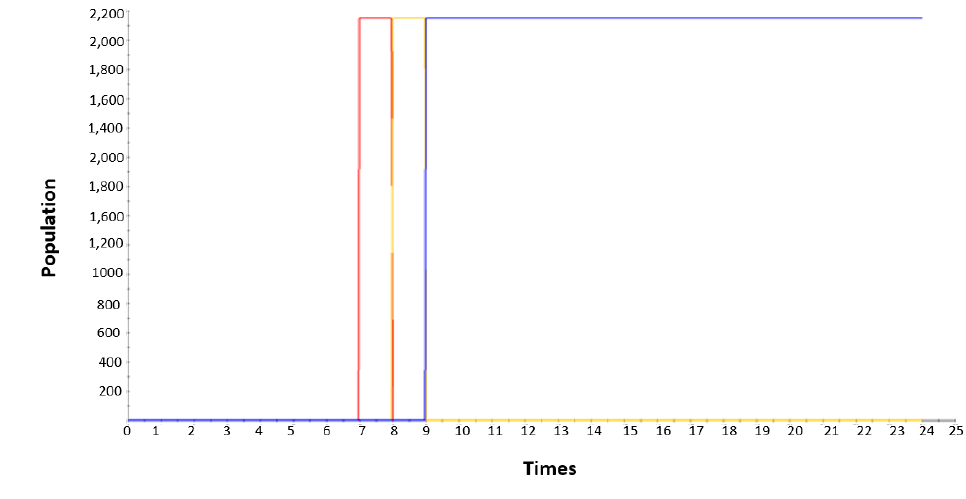
Figure 8. Estimated impact for contaminant at one of the small isolated networks.